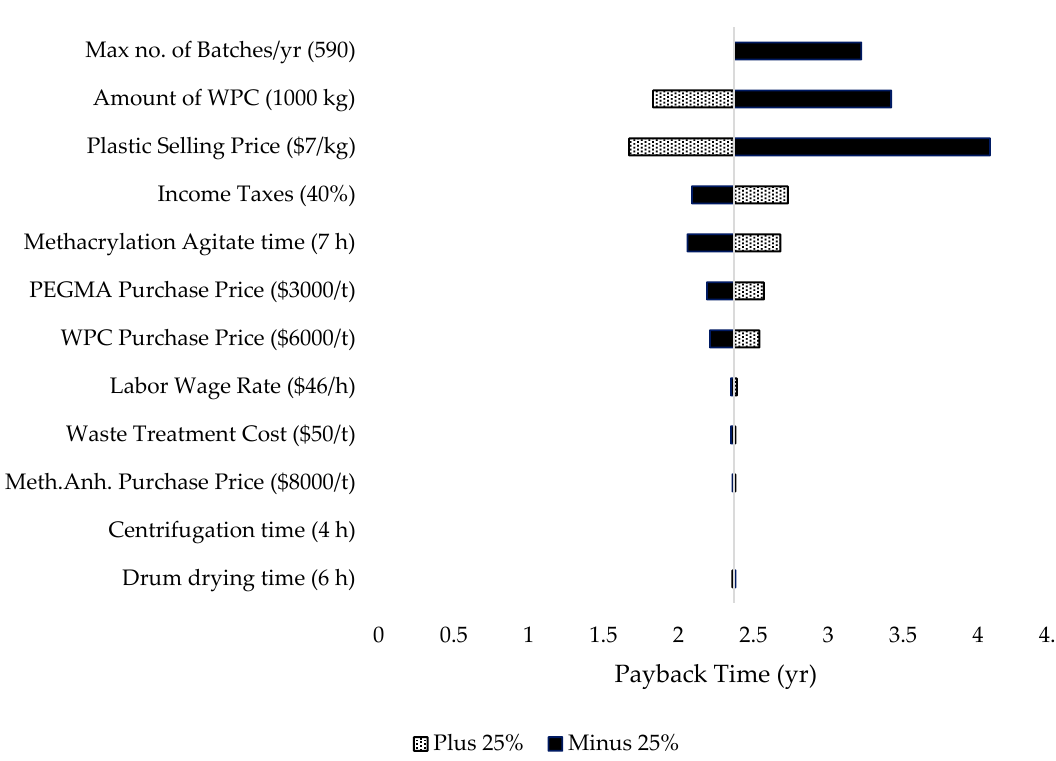
Figure 3. Tornado chart showing the sensitivity of payback time for different important parameters (the base case values for each parameter are displayed in brackets). Filled bars represent increase of 25% compared to their base case values whereas patterned bars represent the reduction of 25% compared to the base case values. The mid-line is the payback time for the base case value, i.e., 2.37 years.